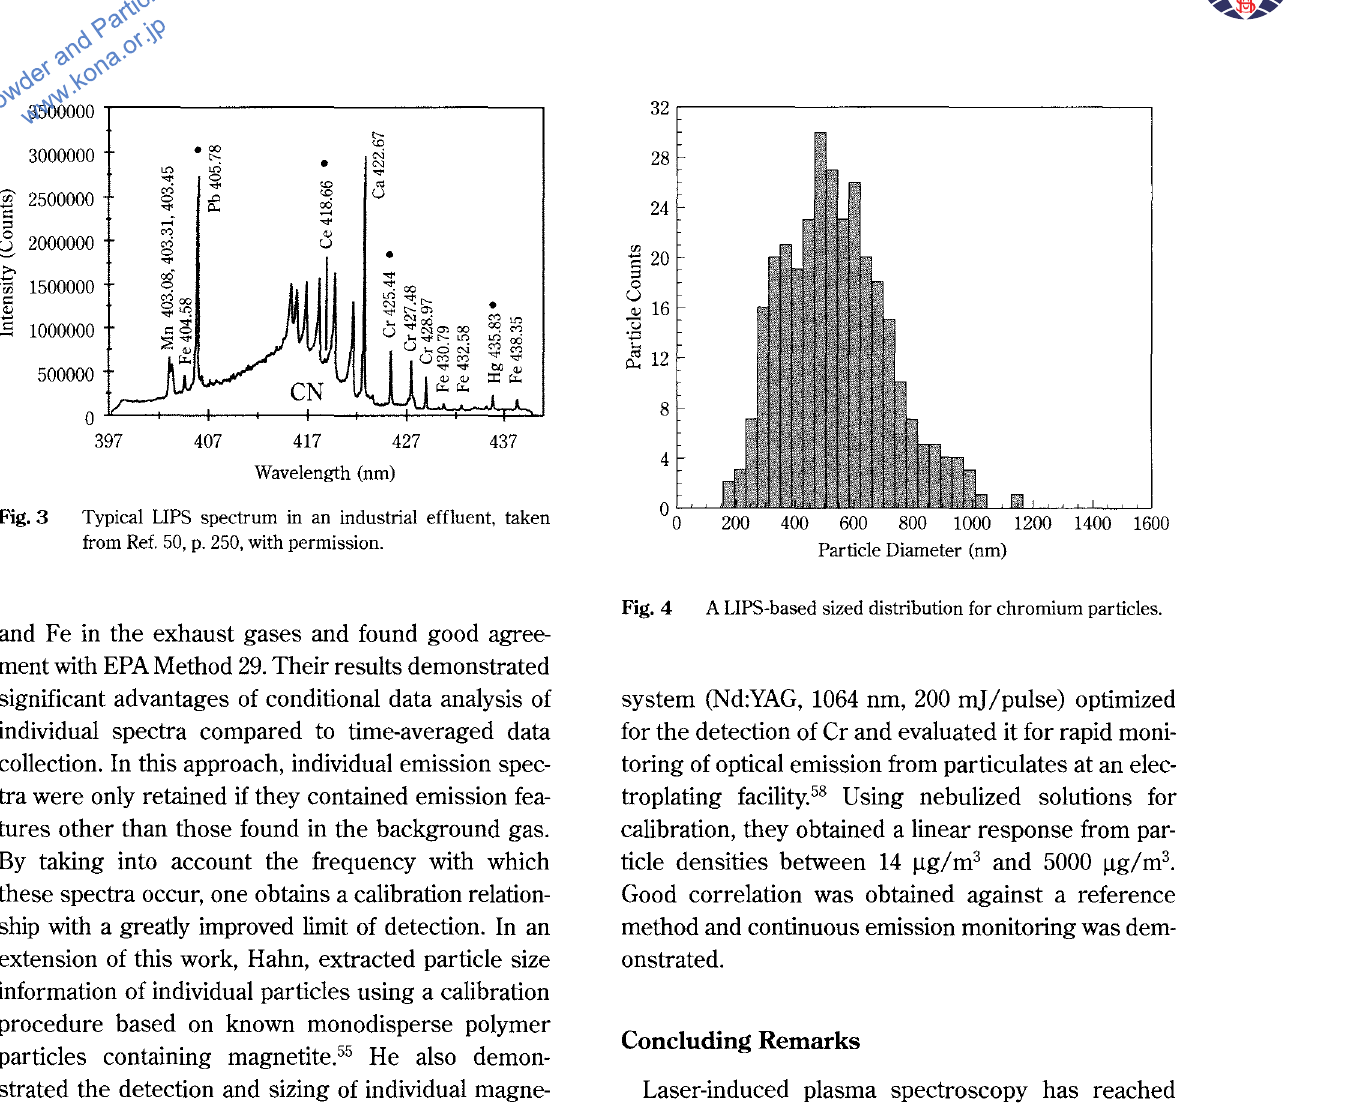
Typical LIPS spectrum in an industrial effluent, taken from Ref. 50, p. 250, with permission.